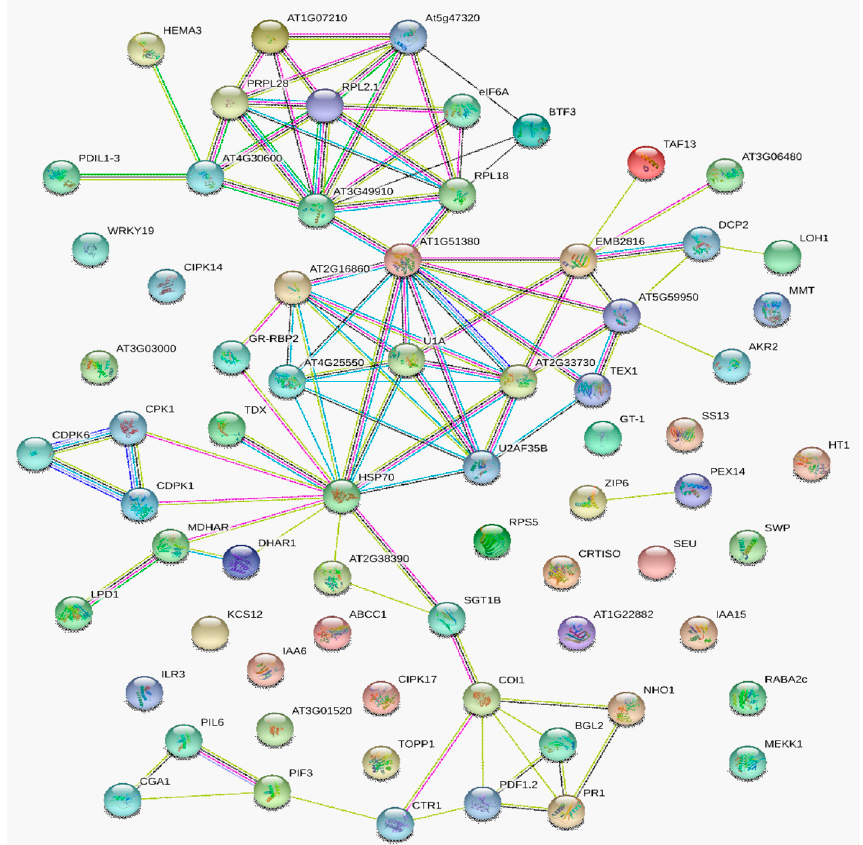
Figure 6. Interaction networks of defense-related DAPs identified by iTRAQ with differential expressed genes in skyblue2 module together. Protein–protein interaction network constituted by DAPs and DEGs identified in N9134 responding to Pst stress. The purples lines represent experimental evidence. The green lines represent gene neighborhood, while the blue lines represent gene co-occurrence database evidence. The yellow lines represent textmining evidence; and the black lines represent the co-expression evidence. HSP70, Heat shock protein 70; U1A, Spliceosomal protein U1A; U2AF35B, Splicing factor U2af small subunit B; DCP2, mRNA-decapping enzyme subunit 2; AT2G16860, pre-mRNA-splicing factor SYF2; AT2G33730, DEAD-box ATP-dependent RNA helicase 21; AT1G51380, DEAD-box ATP-dependent RNA helicase 34; PRPL28, 60S ribosomal protein L28-1; AT3G49910, 60S ribosomal protein L26-1; AT4G25550, Cleavage/polyadenylation specificity factor; AT3G03000, Putative calcium-binding protein CML18; GR-RBP2, Glycine-rich RNA-binding protein 2; PIL6, Transcription factor PIF5; RPS5, Resistant to p. syringae 5; CDPK6, Calcium-dependent protein kinase 6; PR1, Pathogenesis-related gene 1.